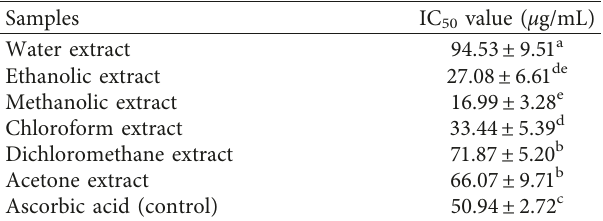
Figure 3: Principal component analysis of the antioxidant and in vitro anti-inflammatory capacities of S. buxifolia extracts by dif- ferent solvents (dichloromethane: CH 2 Cl 2 ; chloroform: CHCl 3 ; ethanol: EtOH; distilled water: H 2 O; acetone: Me 2 CO; and methanol: MeOH). PCAs show the first (PC1) and second (PC2) principal components. Table 2: The 50% inhibitory concentration (IC 50 ) values of DPPH scavenging activity of different S. buxifolia